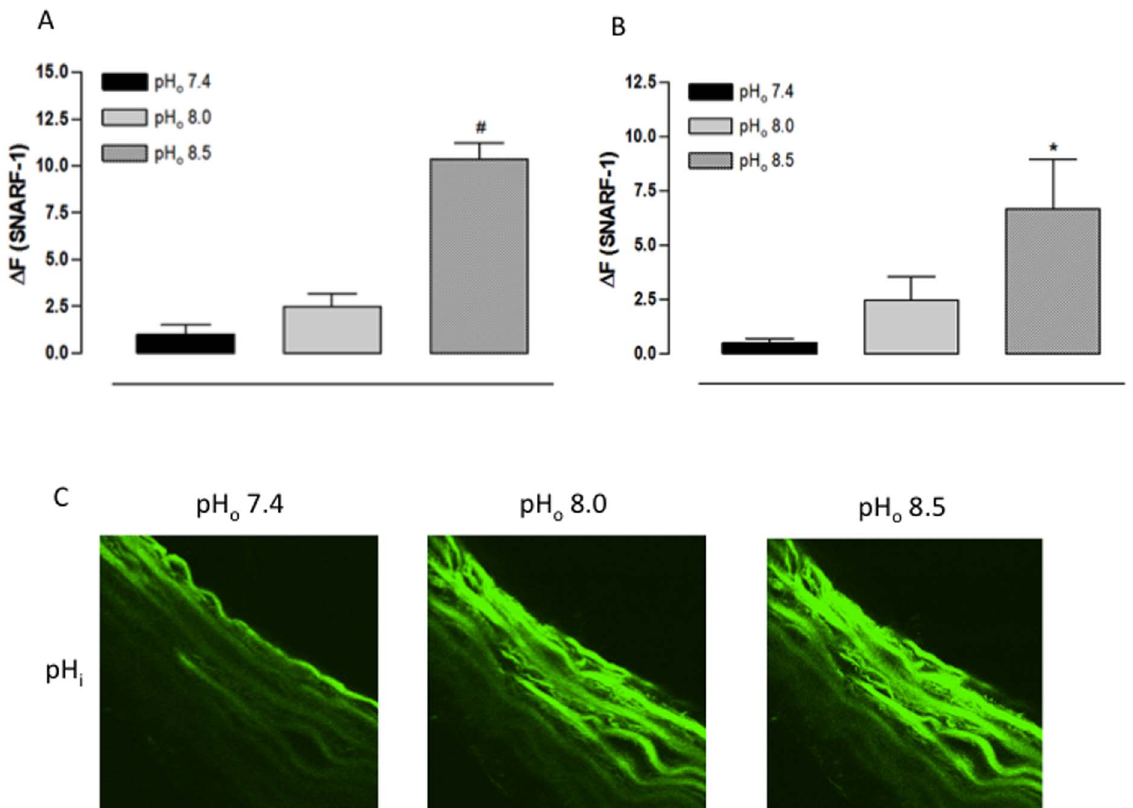
Figure 2. Effect of extracellular alkalinization on pH i of rat aorta cross sections assessed using a confocal scanning laser microscope. A) Fluorescence intensity for endothelial layer. B) Fluorescence intensity for muscular layer. C) Representative confocal photomicrograph of one aorta cross section. Aorta cross sections were loaded with SNARF-1 (10 m M) and analyzed by confocal microscopy. Aorta cross sections were stimulated at 3 rd and 9 th min with Hanks alkalinized solution pH 8.0 and 8.5, respectively. NaOH was used to change the pH of Hanks solution; Hanks solution pH 7.4 served as control. Fluorescence intensity was measured before the stimulus (F) and at 6 th min after the stimulus for each pH o value (F pH ). Results are reported as D F=F pH – F. All values are means 6 SEM (n=7). One-way ANOVA, Bonferroni’s post-test, # p , 0.001 versus control, * p , 0.05 versus control.